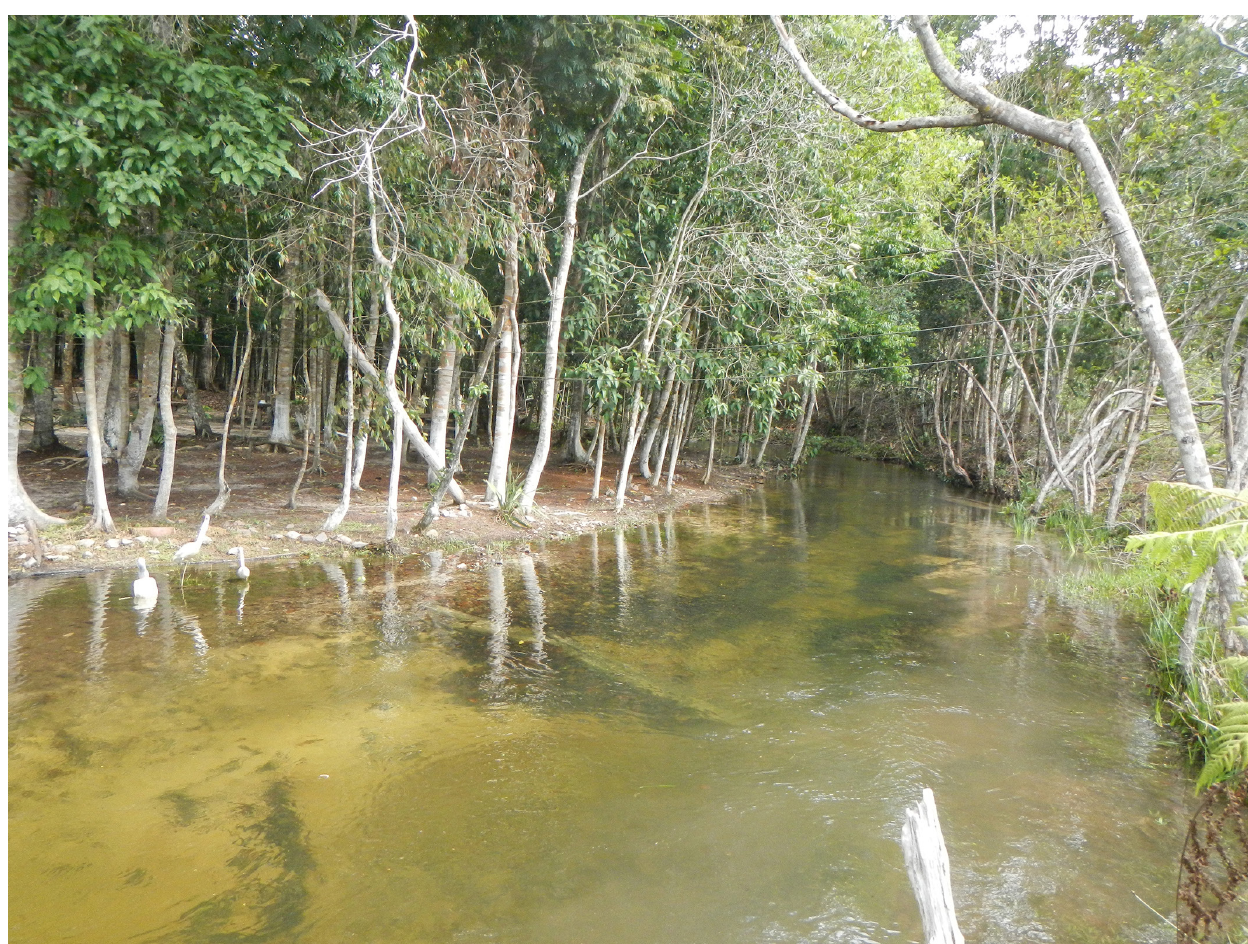
FIGURE 7 | Type-locality of Moenkhausia cambacica , tributary of igarapé Ávila, upper rio Machado, rio Madeira basin, Vilhena, Rondônia,